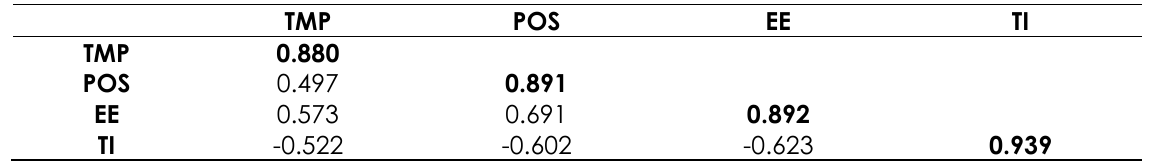
Fornell-Larcker